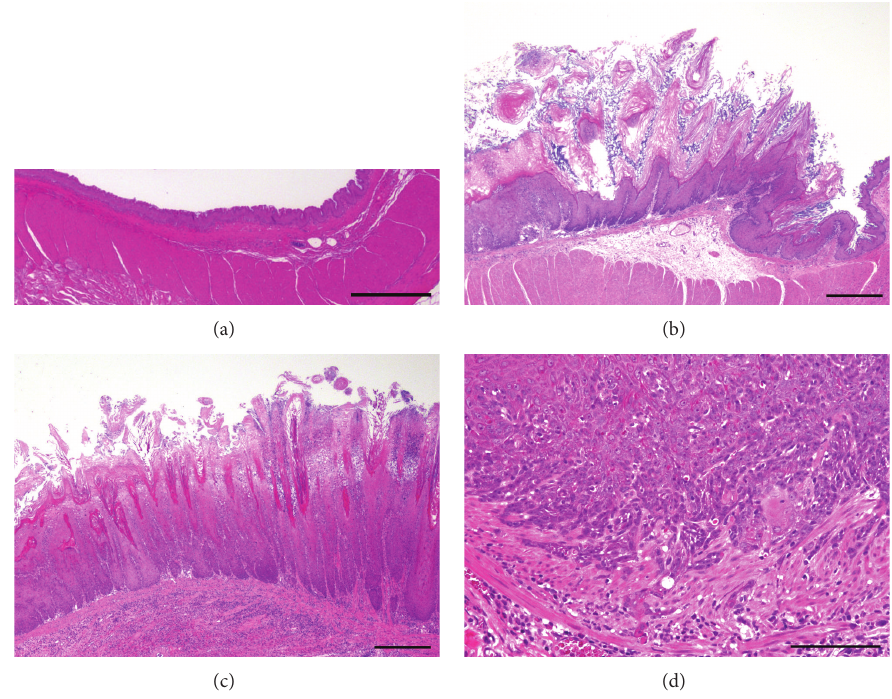
Figure 2: Mucosal hyperplasia and squamous cell carcinoma induced by C. albicans. (a) Normal forestomach mucosa in the C group. Scale bar, 500 𝜇 m. (b) Mild hyperplasia of mucosal squamous epithelium in the AL group. Scale bar, 500 𝜇 m. (c) Severe hyperplasia of forestomach mucosal squamous epithelium in the AC group. Neutrophils accumulate in surface mucosal epithelial layer, and lymphocytes and plasma cells infiltrate throughout the entire submucosal layer. Scale bar, 500 𝜇 m. (d) Squamous cell carcinoma of the forestomach in the AC group. Scale bar, 100 𝜇